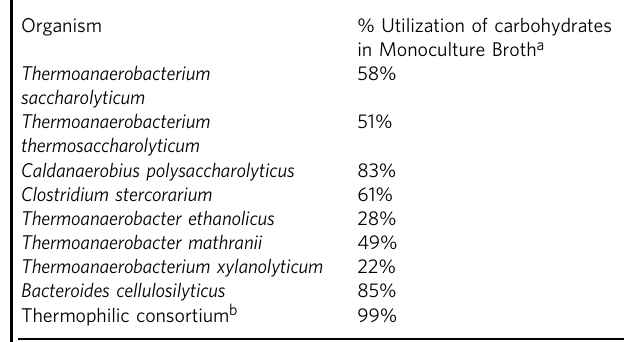
Table 2 Utilization of carbohydrates in Monoculture